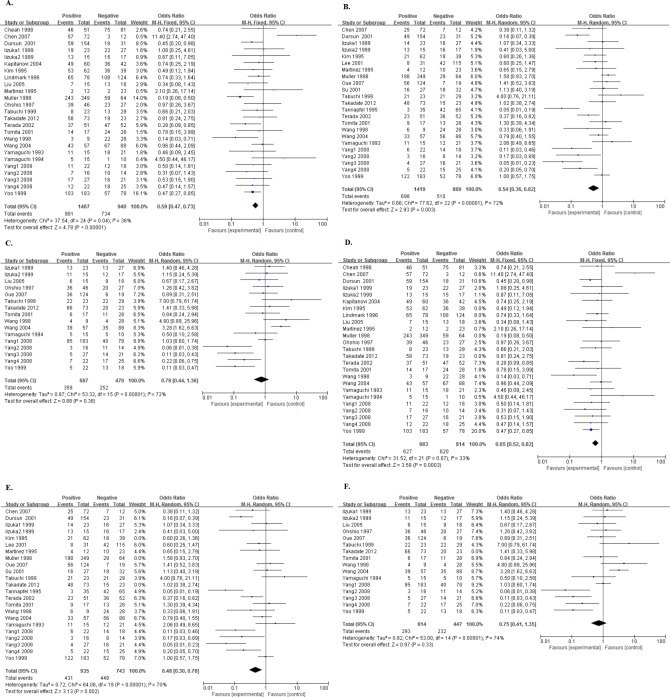
Forest plot of odds ratio (OR) for the association between NME1 overexpression and clinical pathological factors in patients with random effects model.A. The ORs for tumor differentiation; B. The ORs for N status; C. The ORs for TNM stage; D. The ORs for tumor differentiation without low cut-offs; E. The ORs for N status without low cut-offs; F. The ORs for TNM stage without low cut-offs.